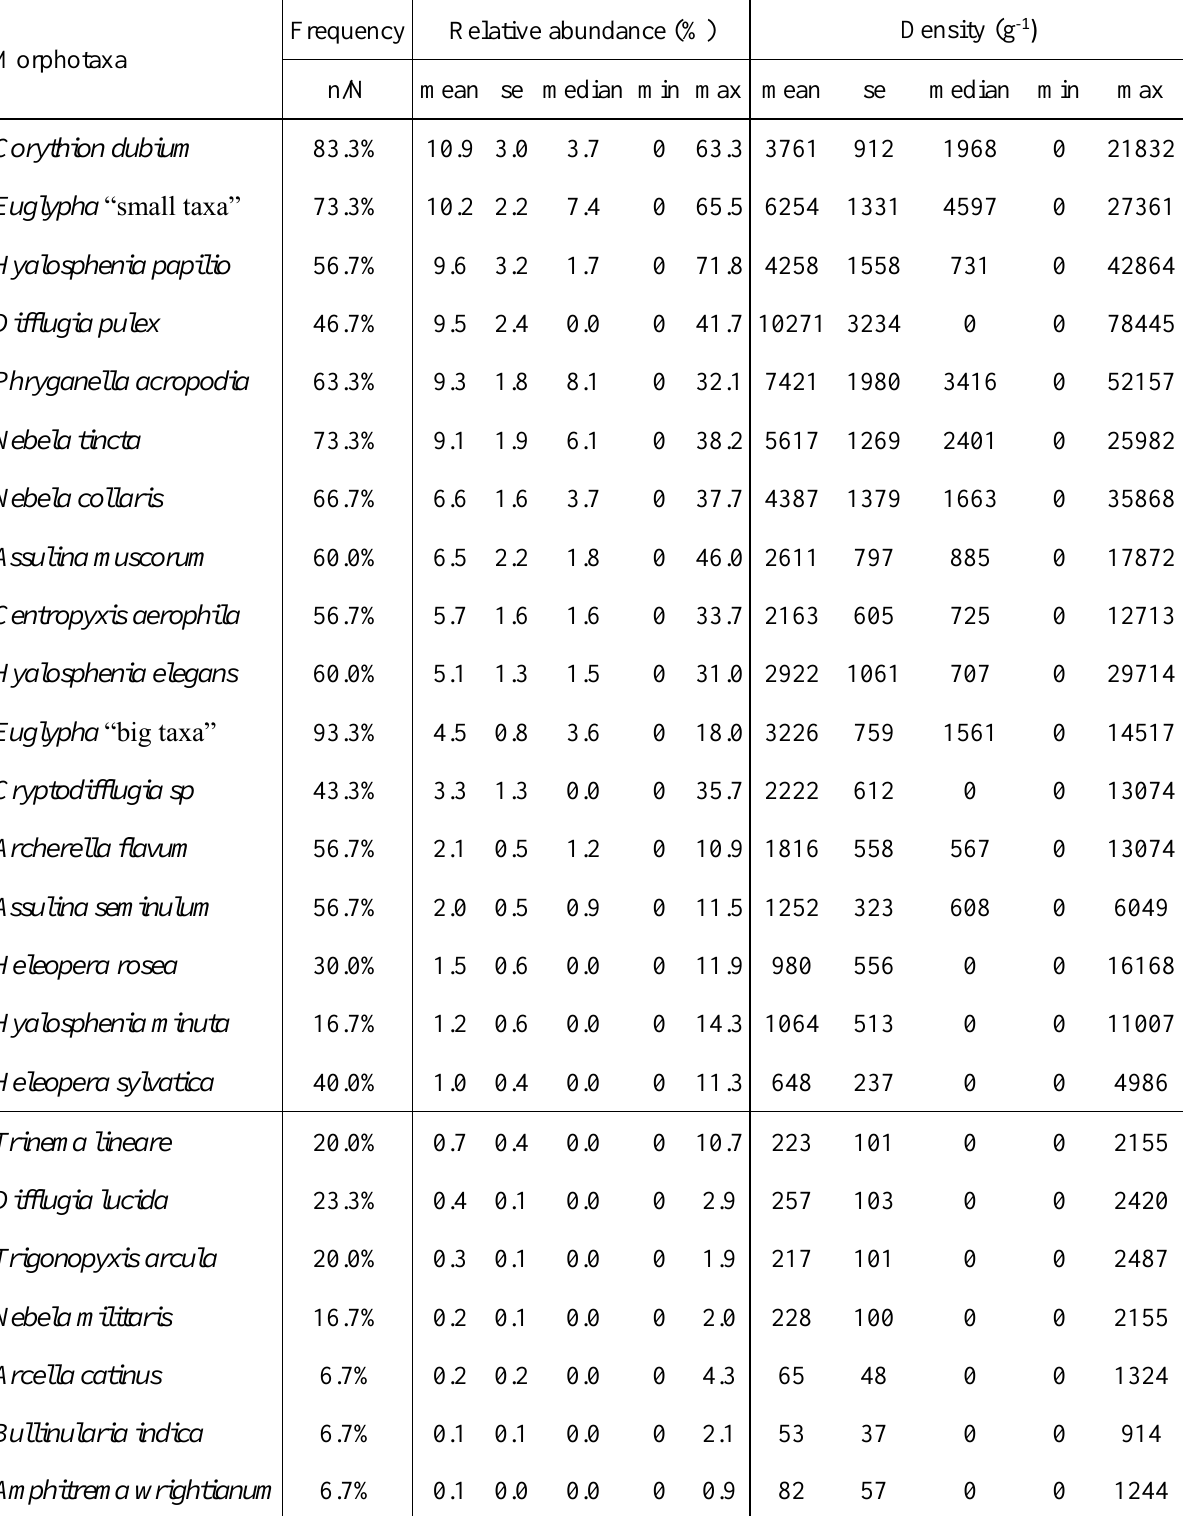
Table A1. Descriptive statistics for the whole testate amoeba dataset (living individuals and empty tests sampled at the Neuchâtel Botanic Garden experimental peatland (BG 2015 and BG 2016) and the Bois-des- Lattes (BdL) reference site). Morphotaxa are listed in order of decreasing abundance, and the low-abundance (< 1 %) taxa in the box at the bottom of the Table were discarded before the analyses. Density is expressed as number of individuals per gram of dry Sphagnum , n = number of sampling plots where the taxa occurred, N = total number of sampling plots